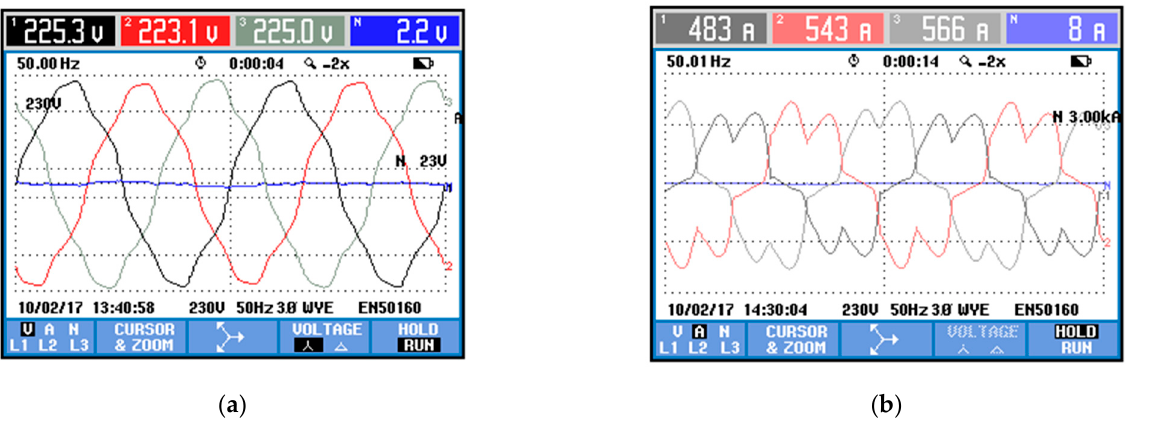
Figure 2. Oscillograms representing: ( a ) voltages; ( b ) current waveforms in the tested object.